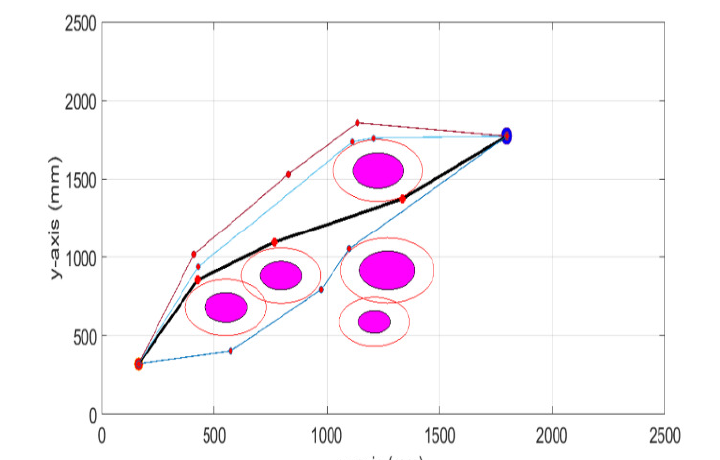
Fig. 12. Path Found by GWO Algorithm for Case 1.